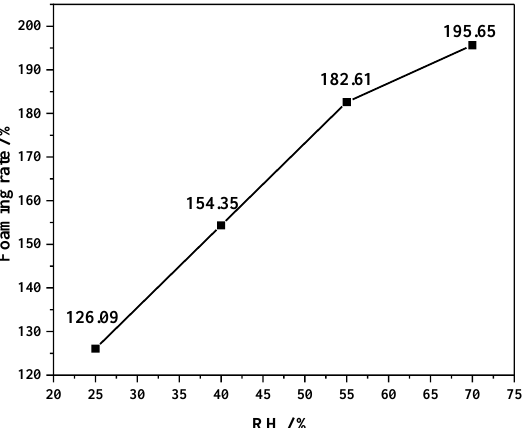
Figure 6. The foaming rate of PU/FA-20% under different humidity